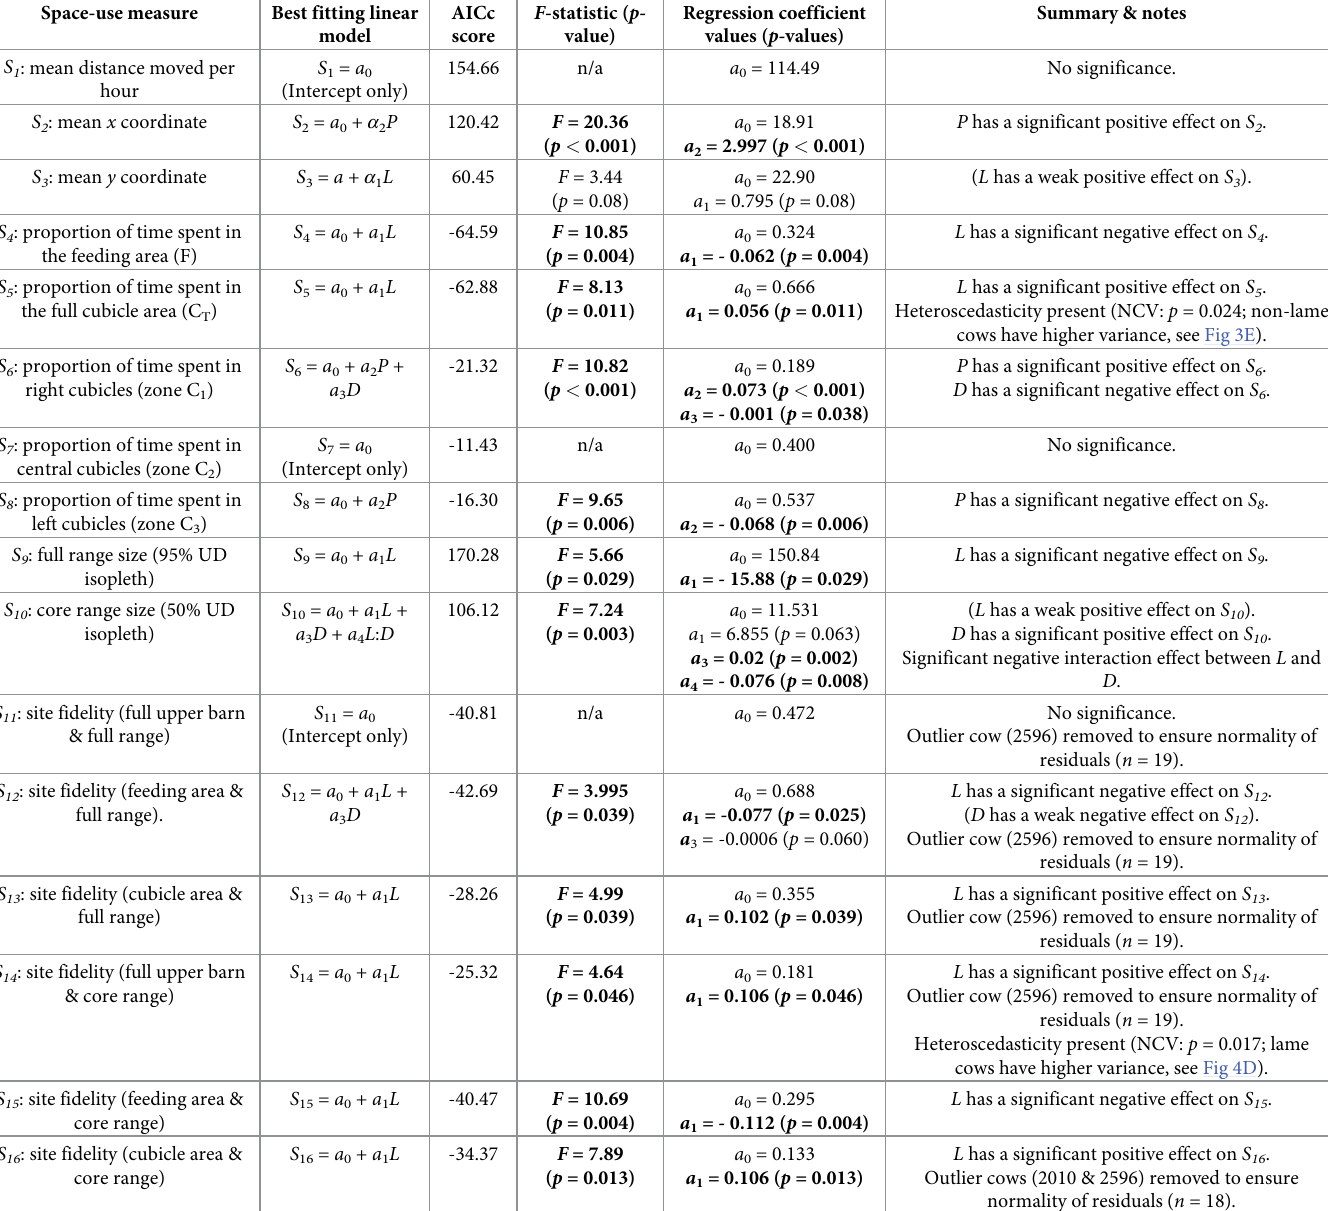
Table 1. Results of model selection for multivariate linear regression models using the predictor variables (lameness, parity and days in milk) for each of the space- use measures considered within the study. Space-use